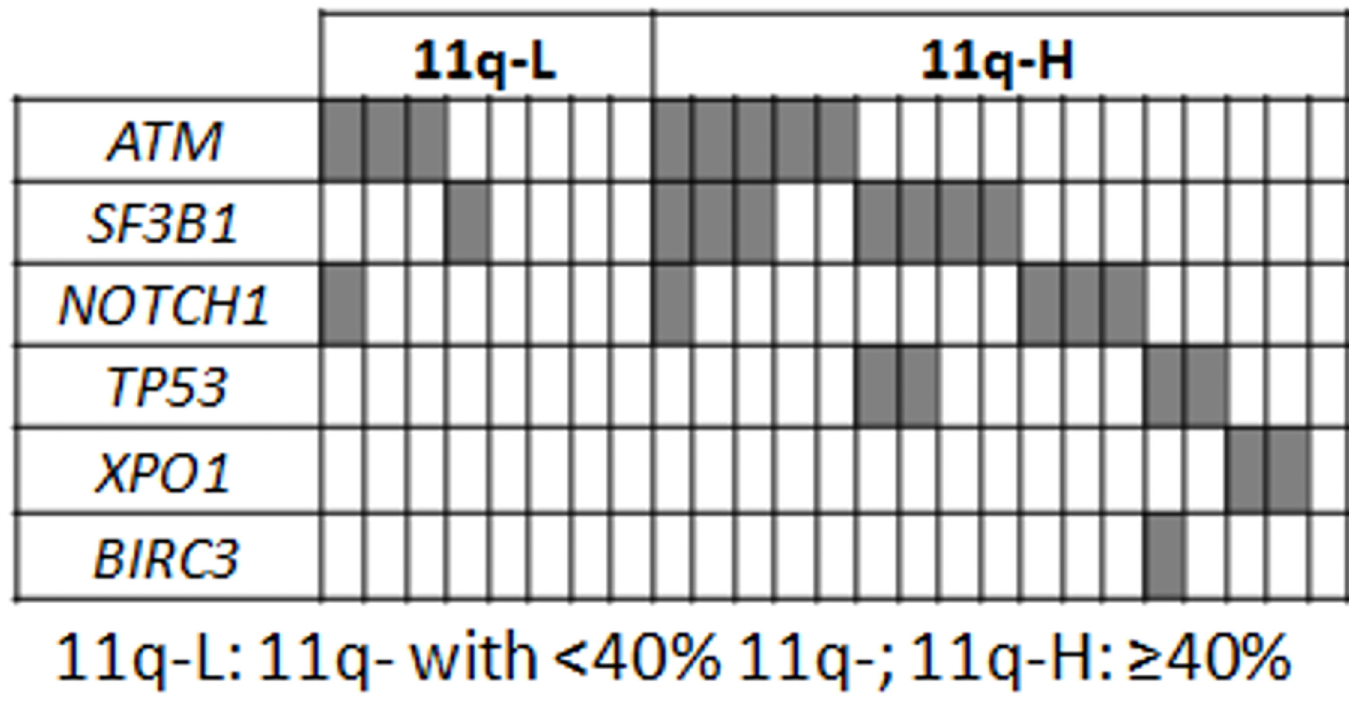
Fig 3. Distribution of mutations of ATM , SF3B1 , NOTCH1 , TP53 , XPO1 and BIRC3 among 11q- CLL patients with respect to the percentage of 11q- cells. In the heat maps, rows correspond to identical genes, and columns represent individual patients color-coded on the basis of gene status (white: wild type; grey: mutated